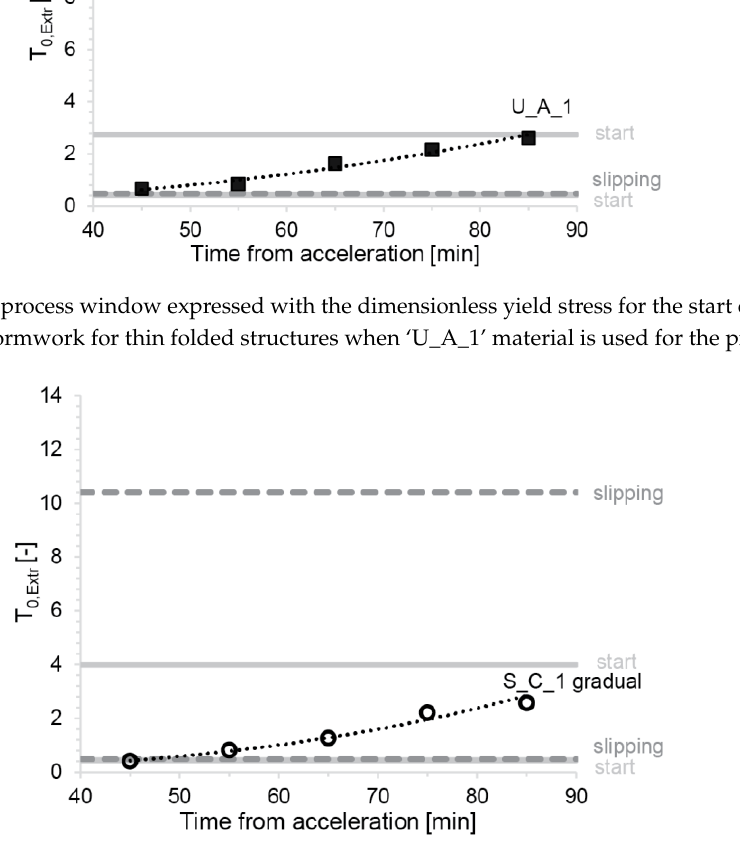
Figure A4. The process window expressed with the dimensionless yield stress for the start of slipping with a formwork for thin folded structures when ‘S_C_1 gradual’ material is used for the process.